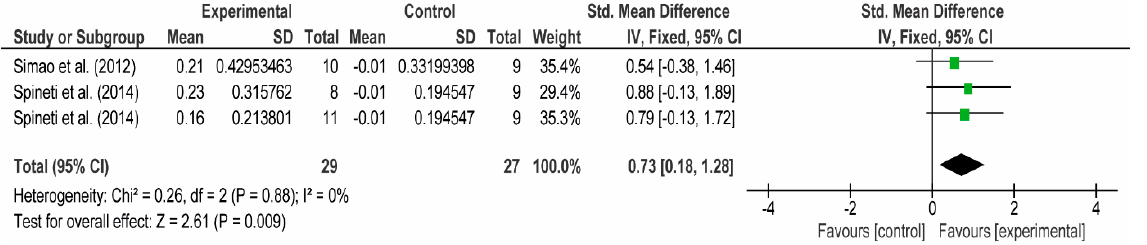
Figure 18. The effect size of 12-weeks of linear periodised resistance training on increasing the biceps brachii MT. The lines for Spineti et al. [90] respectively represent linear periodised large to small muscle training and small to large muscle training groups.